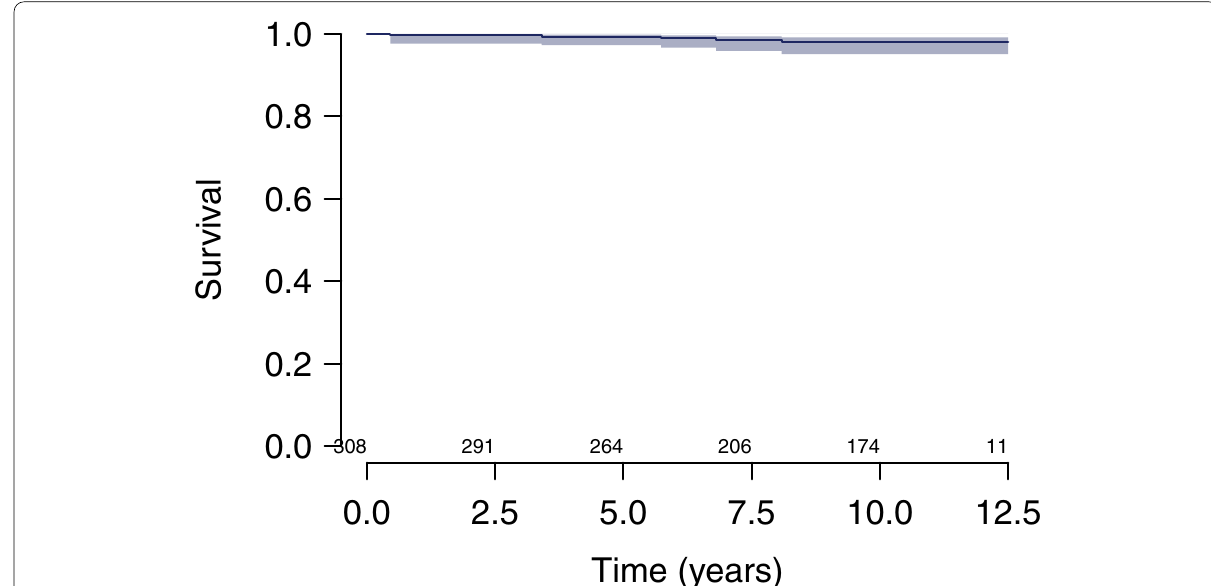
Fig. 2 Survival at 10 years estimated using the KM method was 98.0% (CI, 95.1–99.2%) considering cup revision for any reason as endpoint